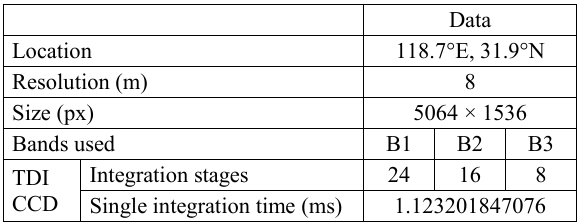
Table 1 . Description of the experimental